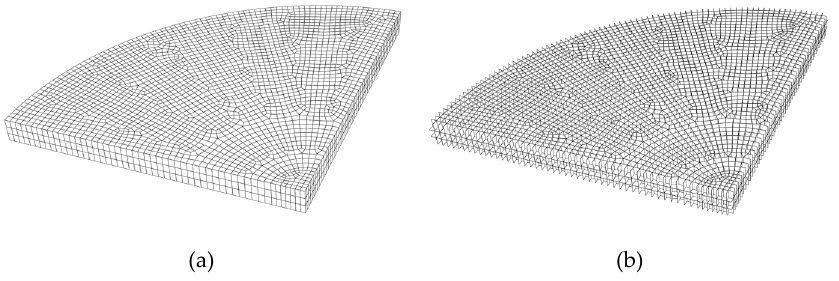
Figure 5. One-quarter mesh model of the plate ( a ) solid element mesh; ( b ) cohesive element mesh.